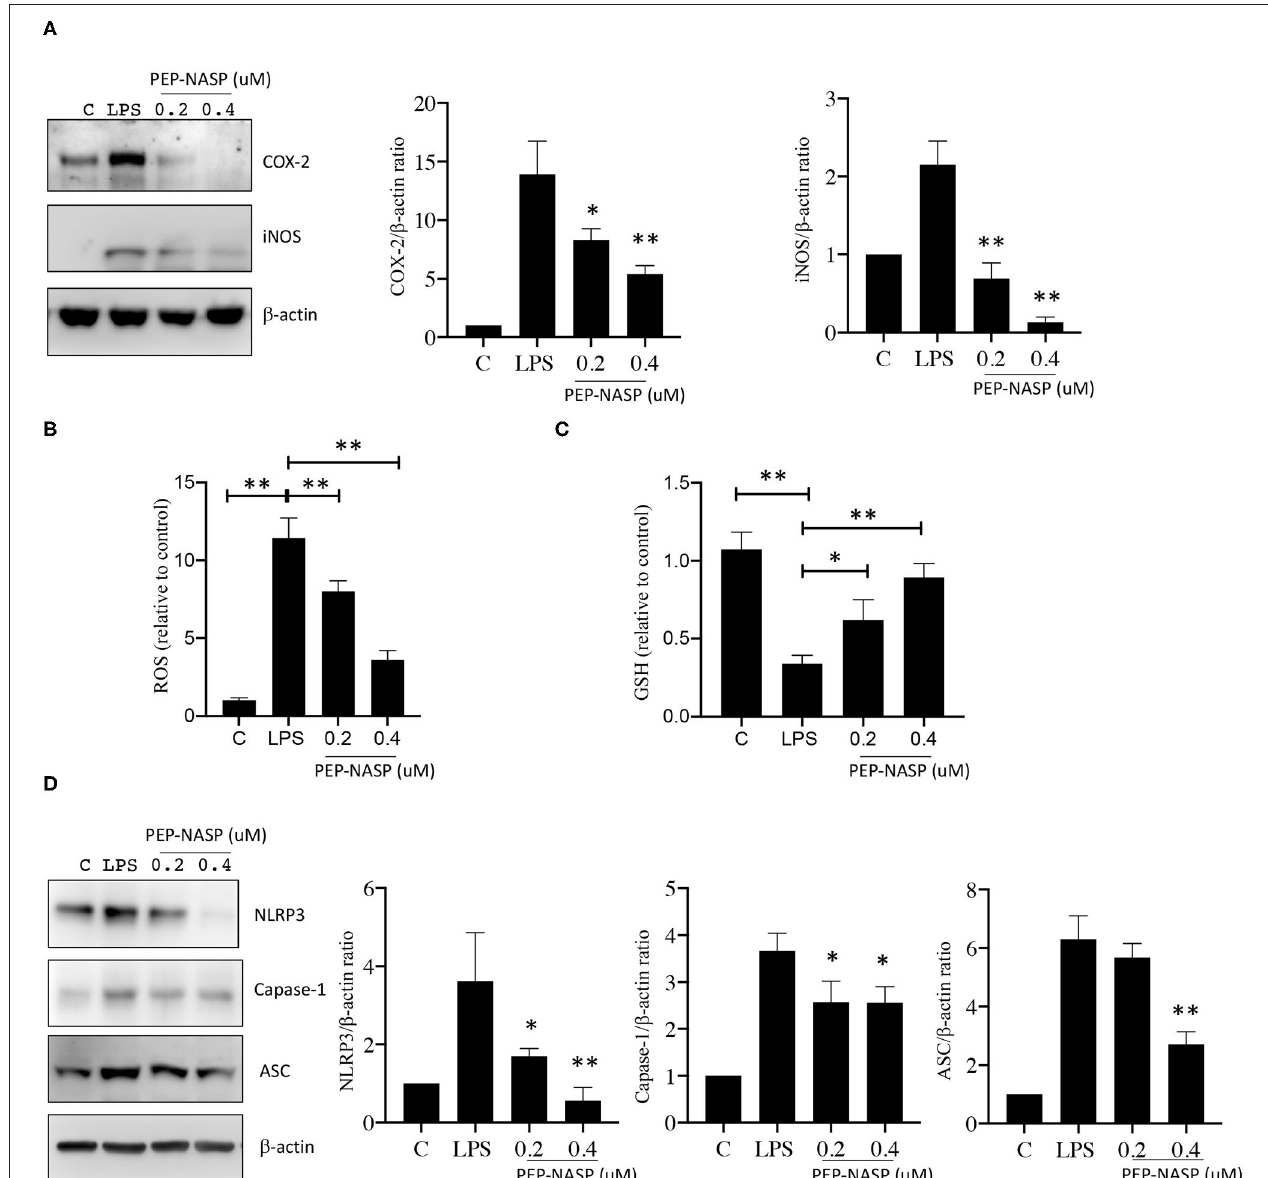
FIGURE 5 | LPS-induced NLRP3 inflammasome and NO production were inhibited by the PEP-NASP. (A) Protein expression levels of COX-2, iNOS, and β -actin in RAW 264.7 cells pretreated with the PEP-NASP and stimulated with LPS as detected by a Western blot analysis. (B) Production of ROS, (C) GSH level and (D) Protein expression levels of NLRP3, caspase-1, ASC, and β -actin in RAW 264.7 cells transduced as in A and stimulated with LPS. Western blots were quantified by normalizing densitometric values to those of β -actin. Data are expressed as mean ± standard error for each group. Signal values were compared to unstimulated conditions. * p < 0.05, ** p < 0.01 (by a one-way ANOVA). Data represent at least three independent